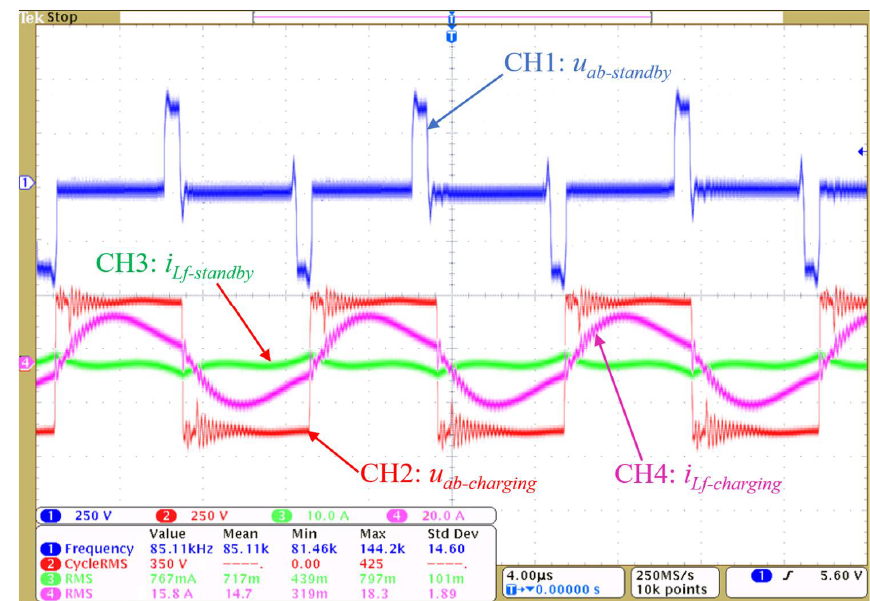
Figure 15. Voltages and currents for different operating modes. CH1 (250 V/div): Input voltage of the stand-by resonant network; CH2 (250 V/div): Input voltage of the charging resonant network, u ab = 350 V; CH3 (10 A/div): Input current of the stand-by resonant network, i Lf 1 = 0.76 A; CH4 (20 A/div): Input current of the charging resonant network, i Lf 2 = 15.8 A.